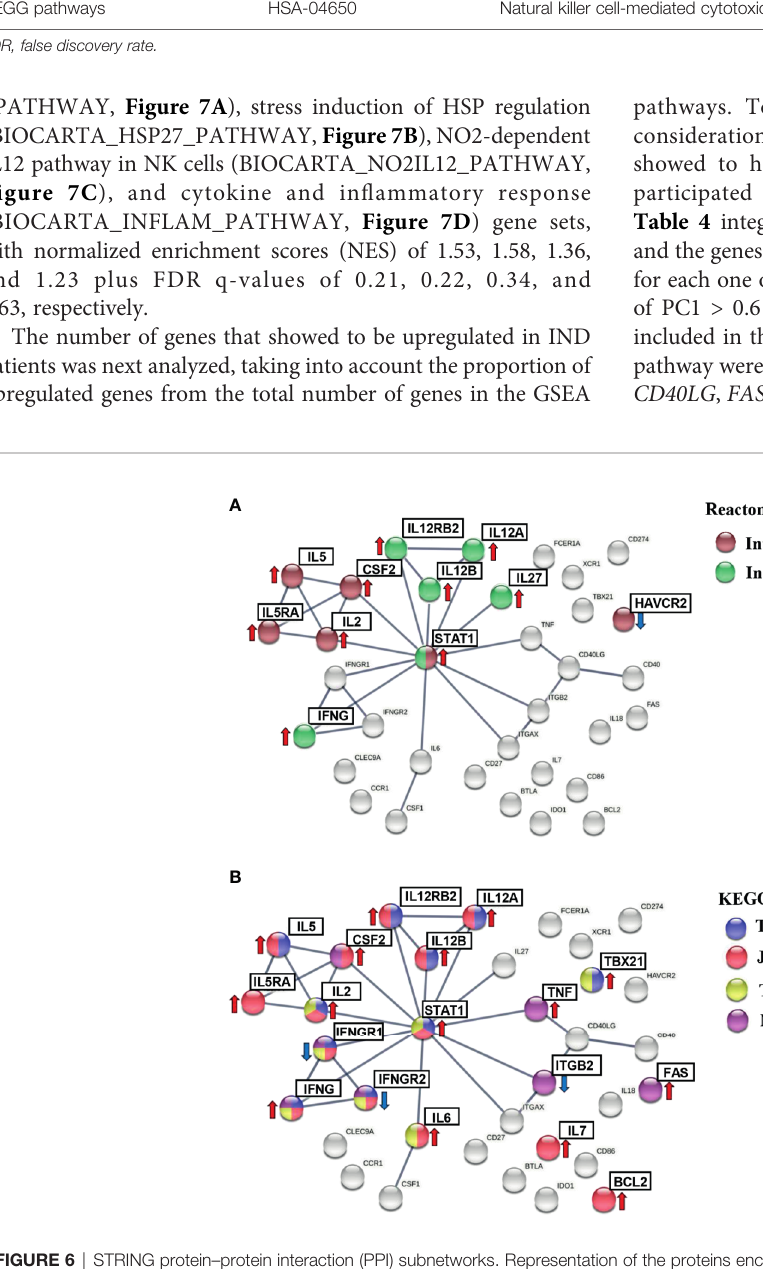
FIGURE 6 | STRING protein – protein interaction (PPI) subnetworks. Representation of the proteins encoded by differentially expressed genes in IND and HD, which are described to be involved in speci fi c pathways. PPI networks were constructed setting the con fi dence score threshold at the highest level (0.9) and active interaction sources, including data from published experiments, databases, co-occurrence, gene fusion, neighborhood, and co-expression, species limited to “ Homo sapiens. ” The colored nodes correspond to proteins involved in each biological pathway: (A) interleukin-2 family signaling (HSA-451927) (brown) and interleukin-12 family signaling (HSA-447115) (green) from the Reactome Pathways Database and (B) Th1 and Th2 cell differentiation (HSA-04658) (blue), Jak-STAT signaling pathway (HSA-04630) (red), Th17 cell differentiation (HSA-04659) (yellow), and natural killer cell-mediated cytotoxicity (HSA-04650) (purple) from the KEGG Pathways Database. The arrows indicate whether the genes encoding these proteins were found to be upregulated (red) or downregulated (blue) in the IND versus HD group.